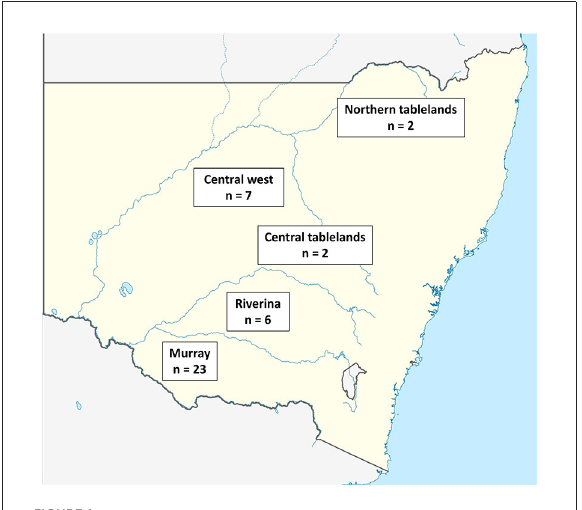
FIGURE1 Map of NSW showing the approximate location of the LLS regions within NSW where participants completed the questionnaire and the number of participating farmers in each